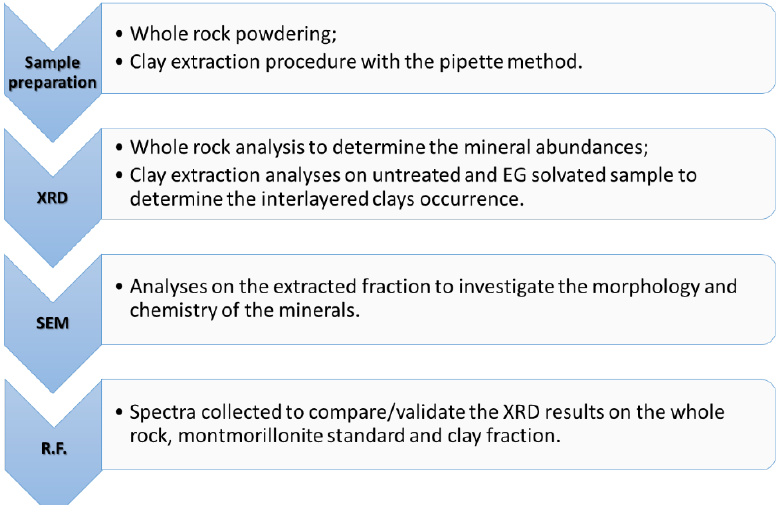
Figure 3. Flow chart indicating the workflow (R.F. = reflectance spectroscopy).